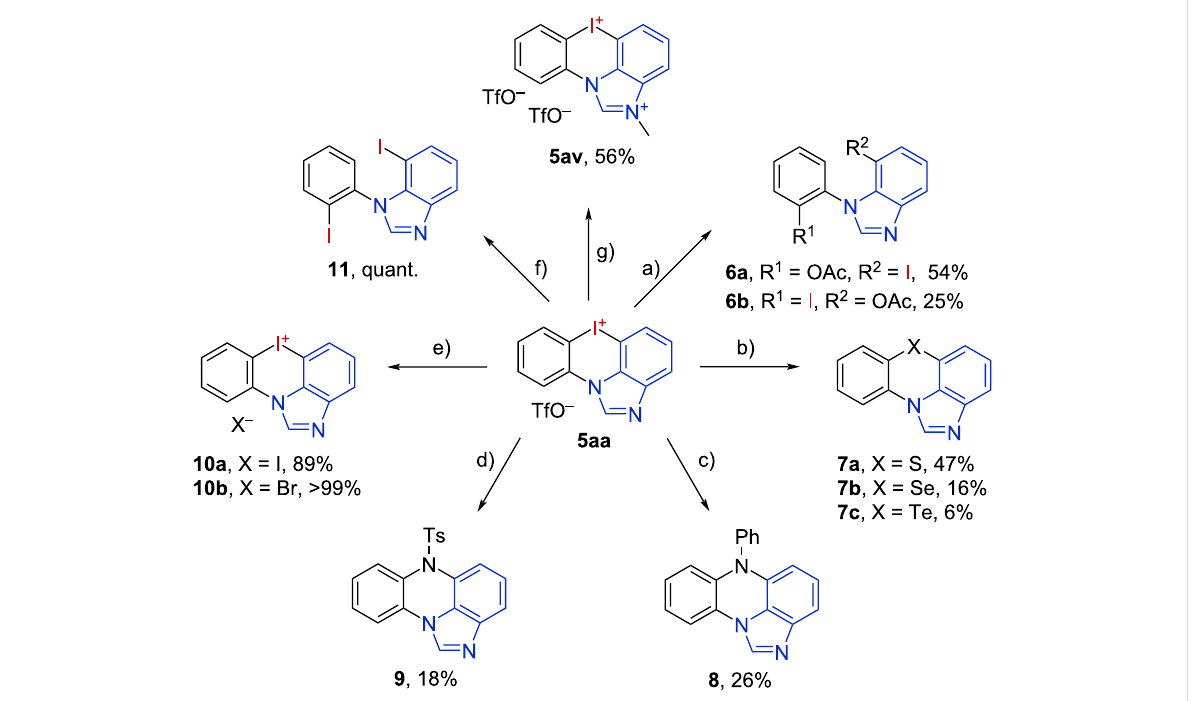
Scheme 1: Derivatizations of the iodonium salt 5aa . a) Ac 2 O, CuSO 4 ·5H 2 O, NaOAc, AcOH, 120 °C, 5 h; b) S 8 /Se/Te, Cs 2 CO 3 , DMSO, rt–100 °C, 2.5–24 h; c) I: PhNH 2 , Cu(OAc) 2 ·H 2 O, Na 2 CO 3 , iPrOH, 40 °C, 17 h, II: CuI, Cs 2 CO 3 , DMF, 120 °C, 40 h; d) TsNH 2 , (CH 2 OH) 2 , iPrOH, Na 2 CO 3